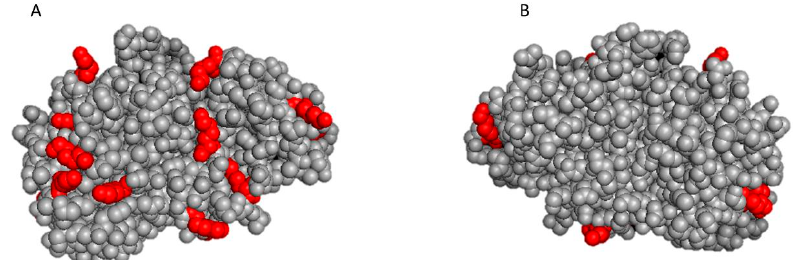
Figure 3. Front (panel A ) and back side (panel B ) in the 3D structure of neutral protease A (protease N) from B. subtilis built in silico using the structure of Staphylococcus aureus metalloproteinase as the template.